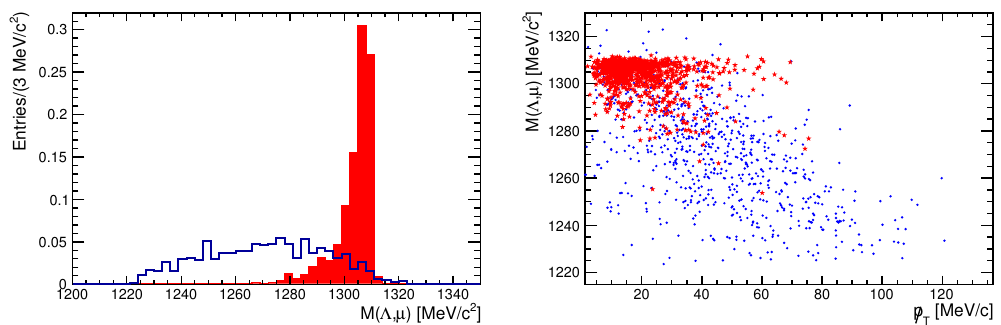
Figure 10 . The left plot shows the reconstructed invariant mass for (cid:4) Signal events are given by a solid blue line, while the (cid:4) (cid:0) red. The right (cid:12)gure shows a scatter plot of the reconstructed mass vs. missing momentum in the plane transverse to the (cid:4) (cid:0) (cid:13)ight direction for signal (blue squares) and (cid:3) stars). Final state radiation in the (cid:4) (cid:0) and (cid:3) decay vertices is not included in the